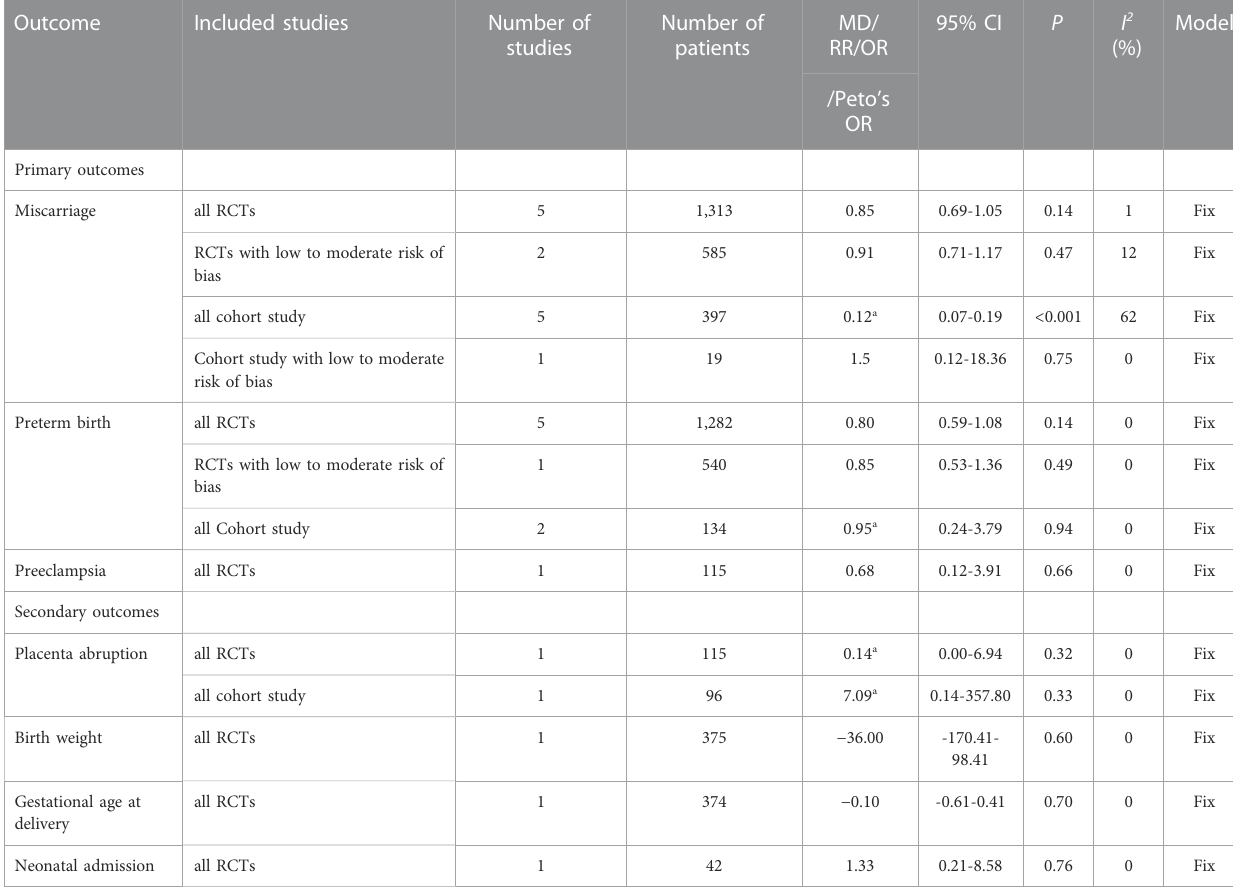
TABLE 2 Results of meta-analysis for all